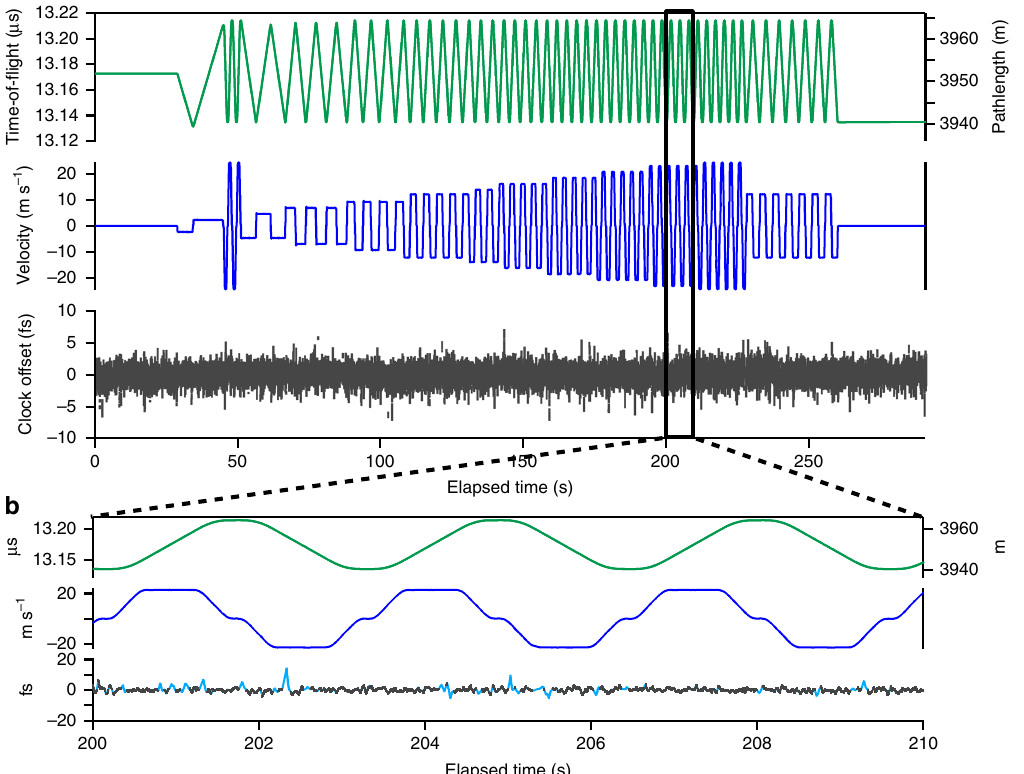
Fig. 2 Synchronization over 4 km with the in-line swept delay line. a The time-of- fl ight and closing velocity are retrieved from the O-TWTFT data. The closing velocity varied from 0 m s − 1 to 24 m s − 1 . The clock time offset is the out-of-loop veri fi cation. During active synchronization (i.e., no long fades) the standard deviation is 1.1 fs. All data are at the 2.2 kHz update rate. b Expanded view. The clocks ’ time offset is shown for all time (cyan) and only during active synchronization, i.e., no turbulence-induced fades (black